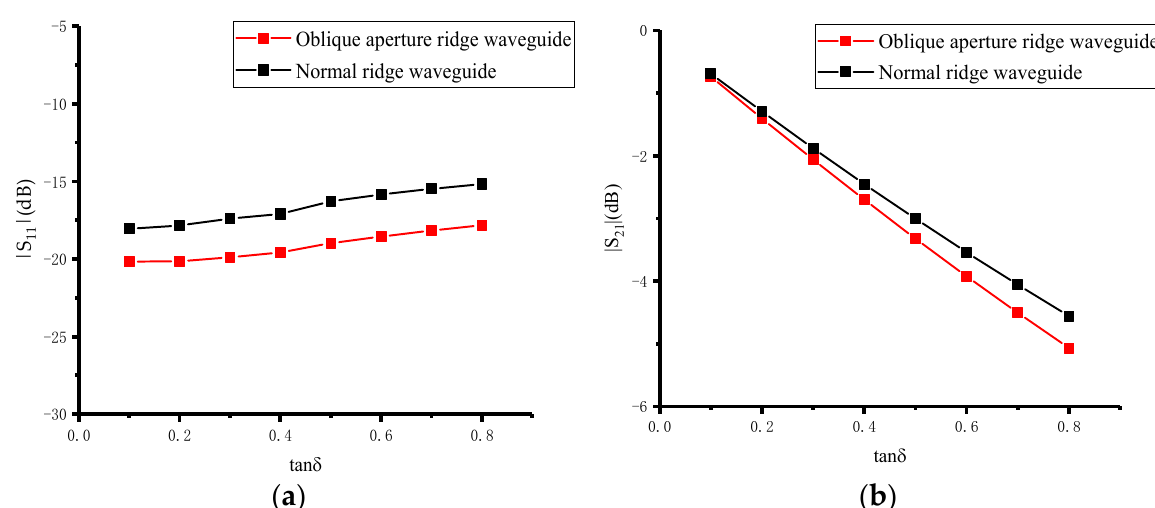
Figure 3. Sensitivity comparison results of oblique aperture ridge waveguide and normal ridge waveguide at ε (cid:4593) = 5: ( a ) Sensitivity comparison results of | S 11 |; ( b ) sensitivity comparison results of | S 21 |.